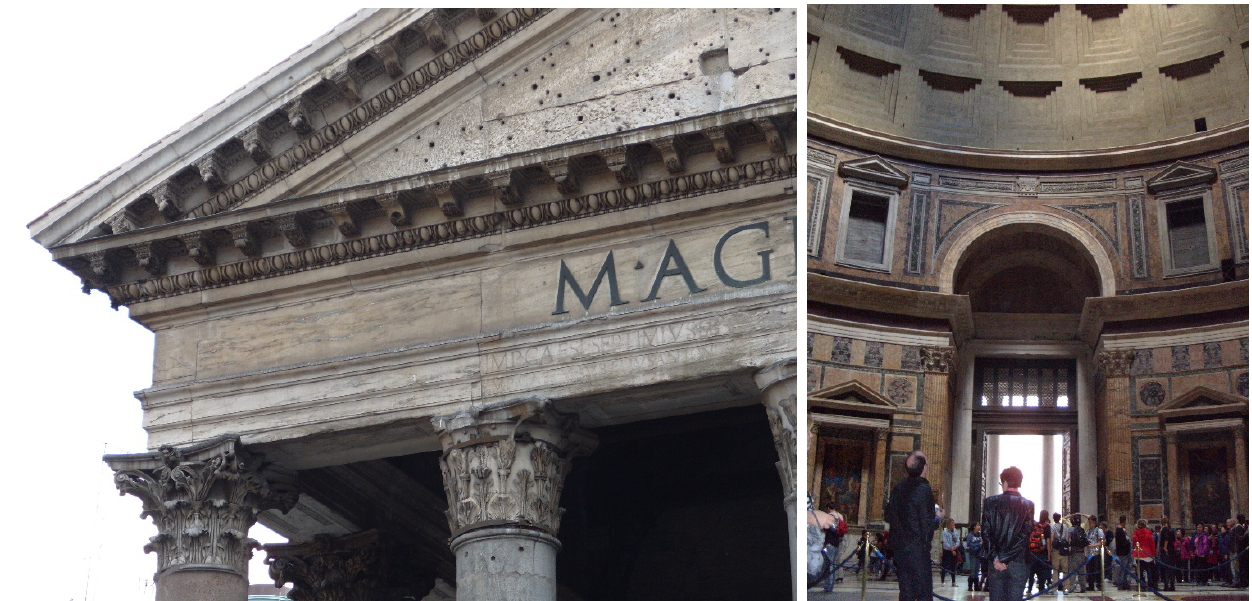
Figure 8. Both exterior and interior architectural details, such as ruin-like column capitals and cornice modillions, communicate different messages and meanings to visitors. Some gaze upon the spherical spatial qualities of the dome ( right ) as others contemplate the ancient construction techniques and vestiges of material decay over thousands of years ( left ). Photographs by author.